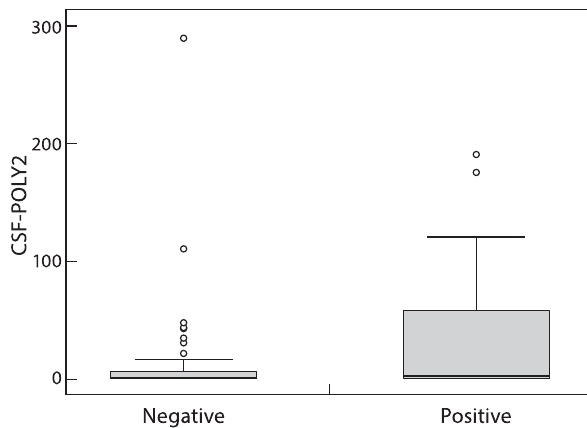
Figure 2: Box plot of CSF lymphocyte cell count distribution for positive and negative viral